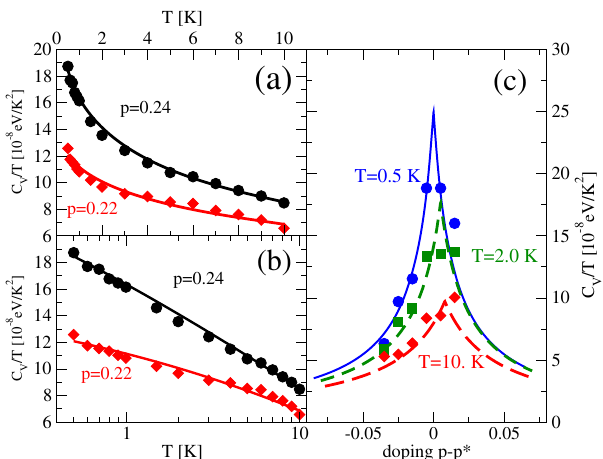
Fig. 3 Speci fi c heat. Temperature dependence of the low-temperature speci fi c heat per unit cell (u.c.) over temperature in Nd – La 2 − x Sr x CuO 4 samples with doping p = 0.24 (black solid line and circles) and p = 0.22 (red solid line and diamonds) in linear ( a ) and semilogarithmic ( b ) [the theoretical curves have been rescaled by an overall factor 1/30, while keeping the relative weight at different doping and temperatures fi xed - see the discussion about this prefactor after Eq. (3) in section “ Speci fi c heat in cuprates ” ]. c Doping dependence of the low-temperature C V / T in Nd – La 2 − x Sr x CuO 4 samples at different temperatures T = 0.5, 2.0, 10.0 K. Symbols represent the experimental data taken from ref. 26 , where the related error bars and the discussion of their origin can also be found, while the lines report our theoretical calculations.